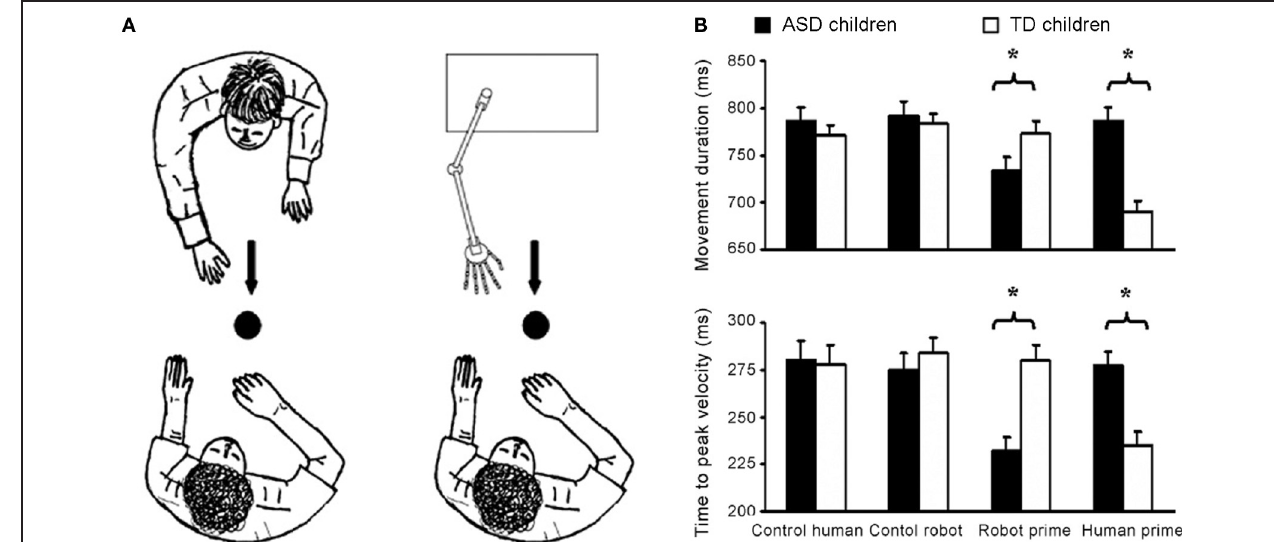
FIGURE 1 | Motor facilitation for robotic but not for human hand movements. (A) Experimental set up. Participants were requested to observe either a human or a robotic arm model performing a reach-to-grasp action toward a spherical object. Subsequently, they were asked to perform the same action toward the same object. Two “control” conditions in which participants performed the movement in the presence of either the static human or robot model were also included. (B) Graphical representation of the significant interaction between group (autistic children, typically developing children) and condition (control human, control robot, robot prime, and human